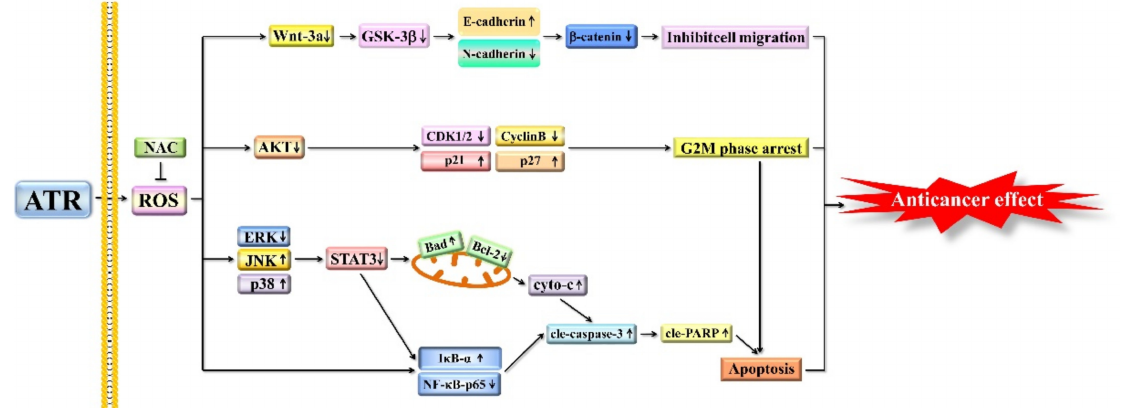
Figure 7. Schematic diagram of anticancer role of ATR in A549 cells. Molecular mechanism of ATR anti- cancer activity related to ROS production, and MAPK, STAT3, NF- κ B, AKT, and Wnt signaling